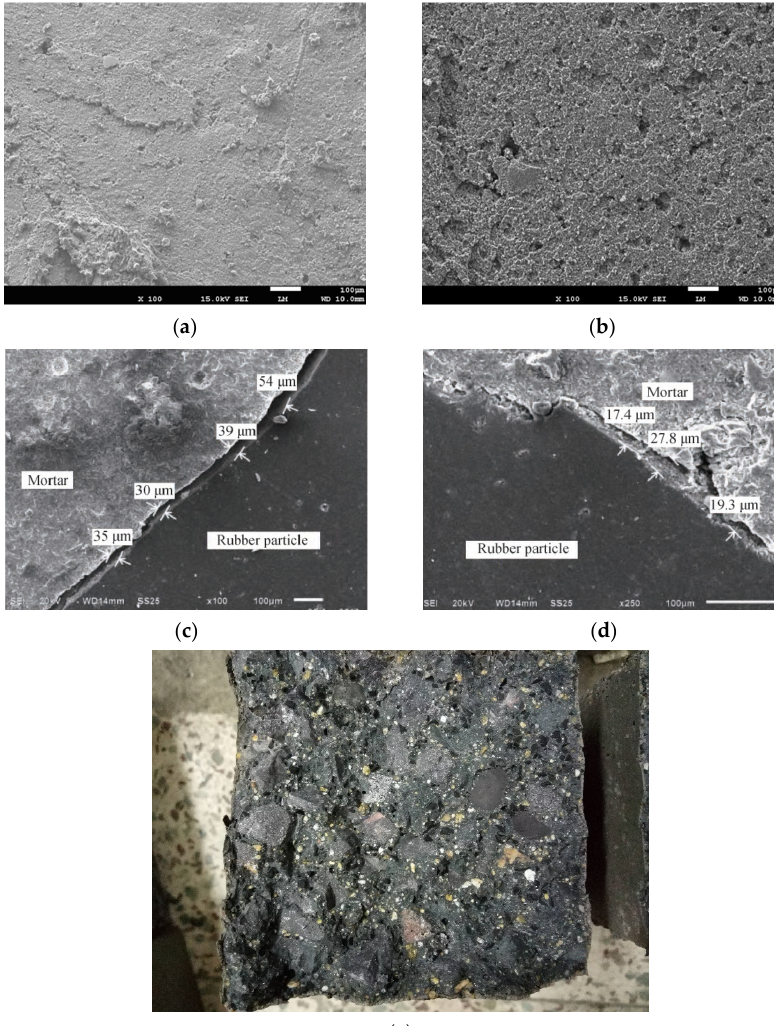
Figure 6. The surface of the rubber particles and their bonding interface with cement matrix: ( a ) The surface of routine rubber particles; ( b ) The surface of pretreated rubber particles; ( c ) The bonding interface of the rubber and cement matrix (×100); ( d ) The bonding interface of the pretreated rubber and cement matrix (×250); and ( e ) Distribution of the rubber particles in concrete. As shown in Figure 6, the surface of the pretreated rubber particle is clean and rough, and the width of an obvious crack along the interface between rubber and cement matrix reduces significantly after pretreatment. This can be attributed to the enhanced superficial adsorption, roughness, and the attenuation of hydrophobicity of rubber powders due to the corrosion of sodium hydroxide [28,46]. Therefore, the pretreatment of rubber particles helped reduce the internal defects between the rubbers and cement matrix, and increased the strength of RUC. However, the increase of concrete strength by enhancing the bonding interface between the rubber and cement matrix is not unlimited, since the rubber parti- cles fill the voids in concrete as rubber aggregate, but they can’t act as the skeleton like sand due to its lower strength and stiffness. Gao et al. [44] and Bompa et al. [56] reported that the added rubber particles in- creased the ductility of concrete, but concrete strength decreased significantly due to the rubber’s low stiffness and surface bonding with cement matrix. Hence, the ductility of the rubberized concrete may be further enhanced due to the elasticity of rubber and the en- hanced interface between the rubber and cement matrix by pretreating the rubber parti- cles. Moreover, lots of concrete internal defects due to a large content of rubber particles may reduce the splitting tensile and flexural strength more rapidly, which is adverse to concrete ductility, hence the values of f f / f cp and f ts / f cp decrease when the content of rubber particles exceeds 15%.